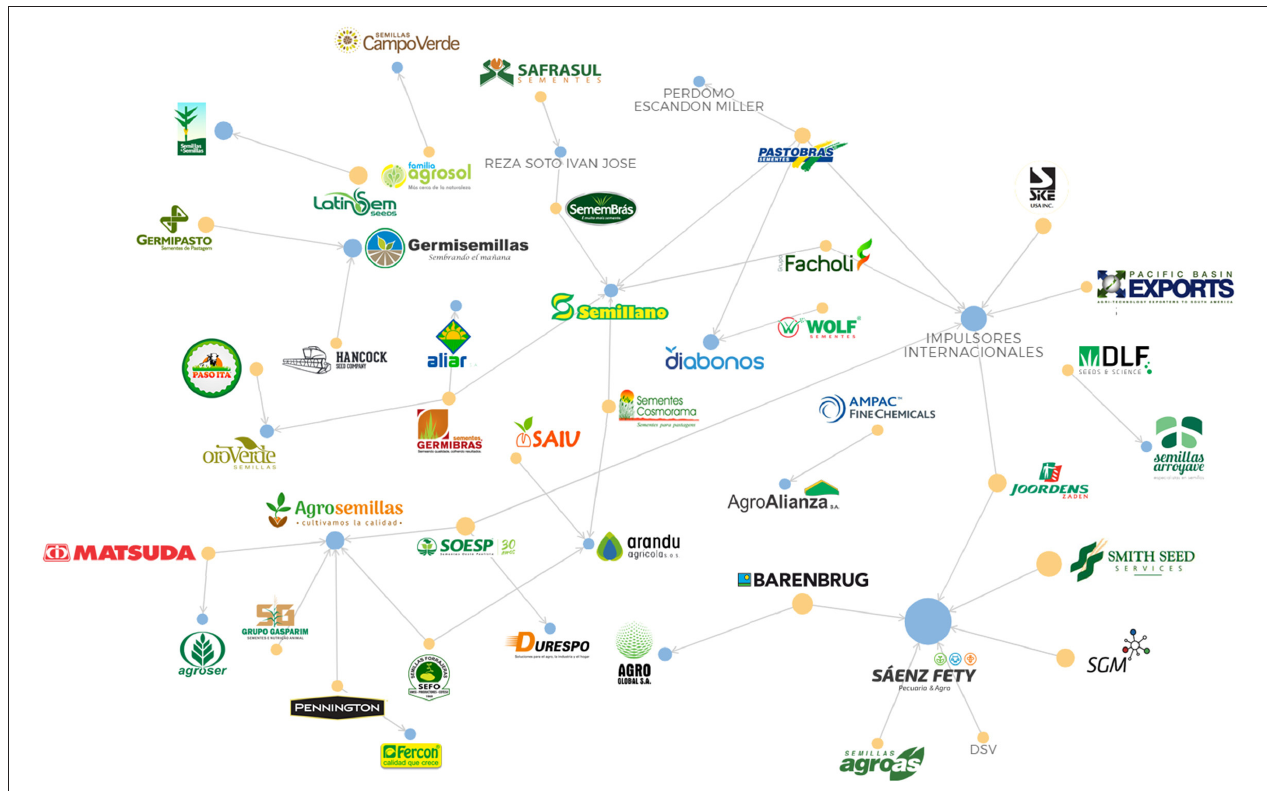
FIGURE 2 | Network of companies that import and export improved forage seeds in Colombia. Own elaboration based on trade statistics from Legiscomex (2020). Note. The blue nodes refer to the importing companies, and the yellow nodes refer to the exporting companies. The size of each node represents the level of participation regarding to the total in imports and exports,